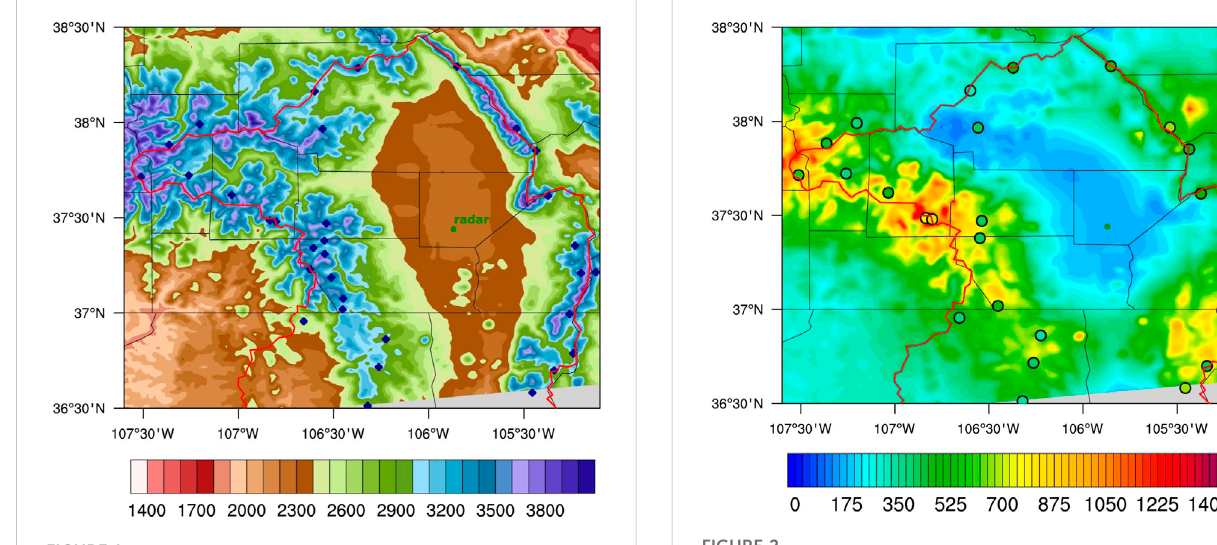
FIGURE 1 Topographywithin thewatermodeldomain,centeredovertheSan Luis valley covered by the Alamosa radar, along with locations of radar and stream fl ow stations. (The unshaded gray area in the lower right- hand corner of this and other plots are outside of the water model domain.).